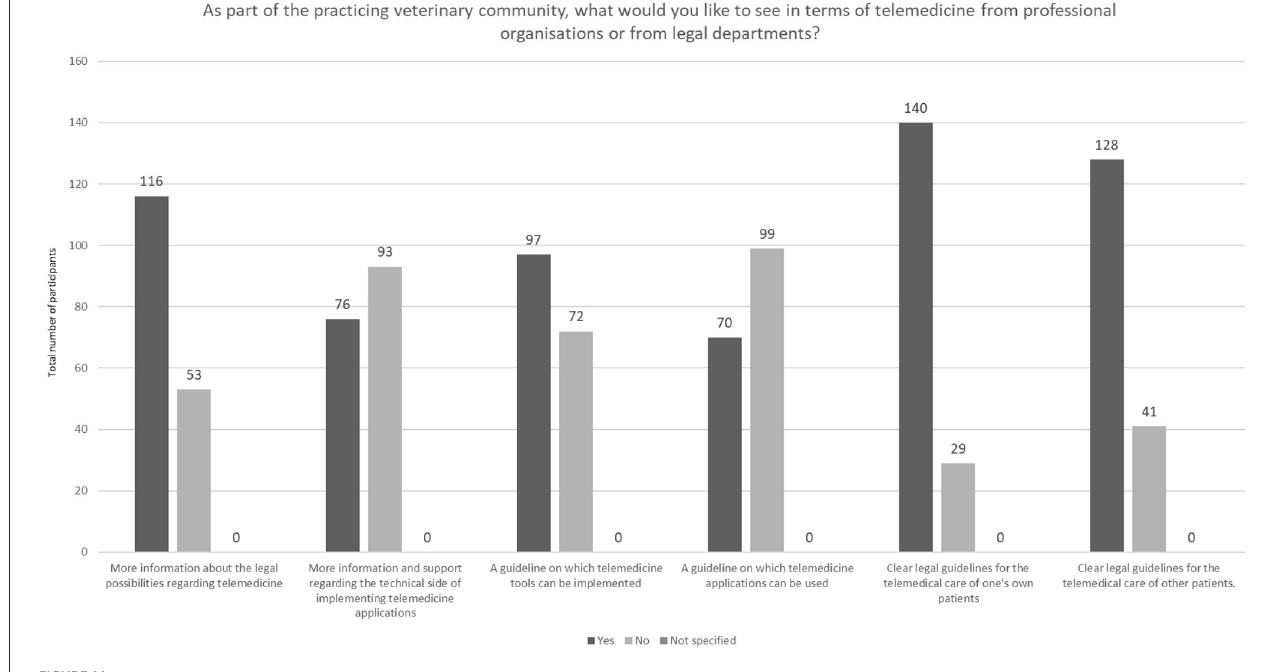
FIGURE11 Needed support and information by legal departments ( N =